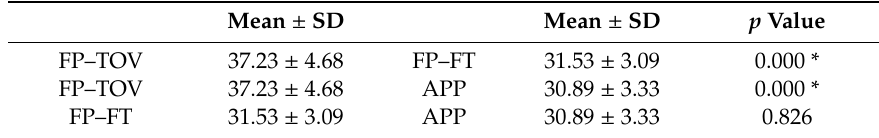
Table 2. Values of the di ff erent methods for measuring SJ jump height.